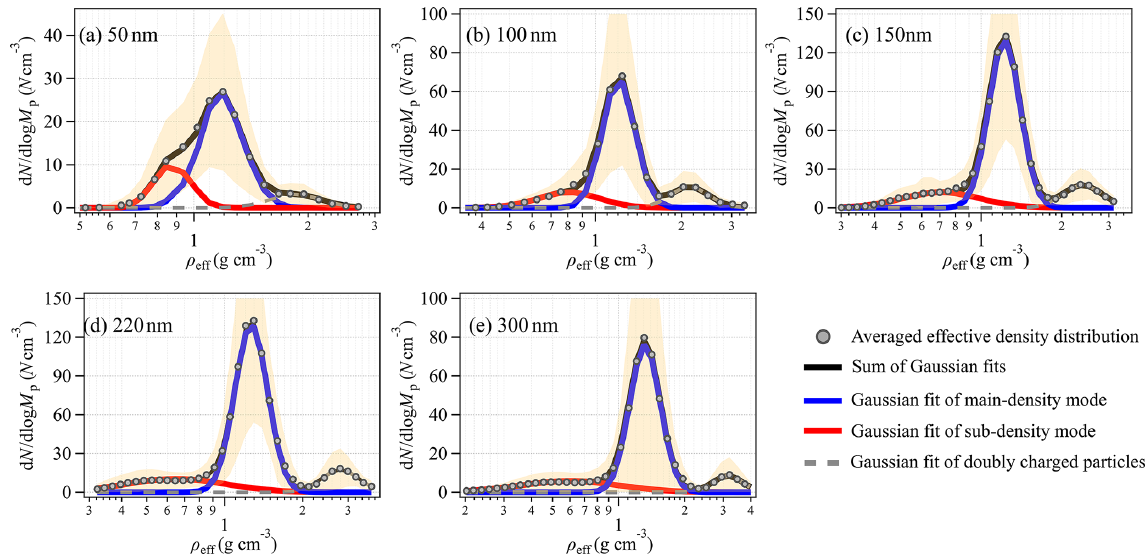
Figure 1. Averaged particle effective density ( ρ eff ) distribution for (a) 50nm, (b) 100nm, (c) 150nm, (d) 220nm, and (e) 300nm particles during the entire sampling period. The grey points represent the measured average effective density distribution, and the yellow shaded area represents the standard deviation of the averaged data. The blue line and red line are the Gaussian fit of the main density mode and sub-density mode at each size, respectively, and the dashed grey line represents Gaussian fit of doubly charged particles. The black line is the sum of the main density mode, sub-density mode, and doubly charged particles. Table 1. The geometric mean effective density ( ρ eff , sub and ρ eff , main ) and standard deviation ( σ sub and σ main ) of the sub-density mode and main density mode and the number fraction ( F sub ) and occurrence frequency of the sub-density mode during the entire sampling period. Size ρ eff , sub ρ eff , main σ main σ sub F sub Frequency (nm) (gcm − 3 ) (gcm − 3 ) (%) (%) 50 0.89 ±